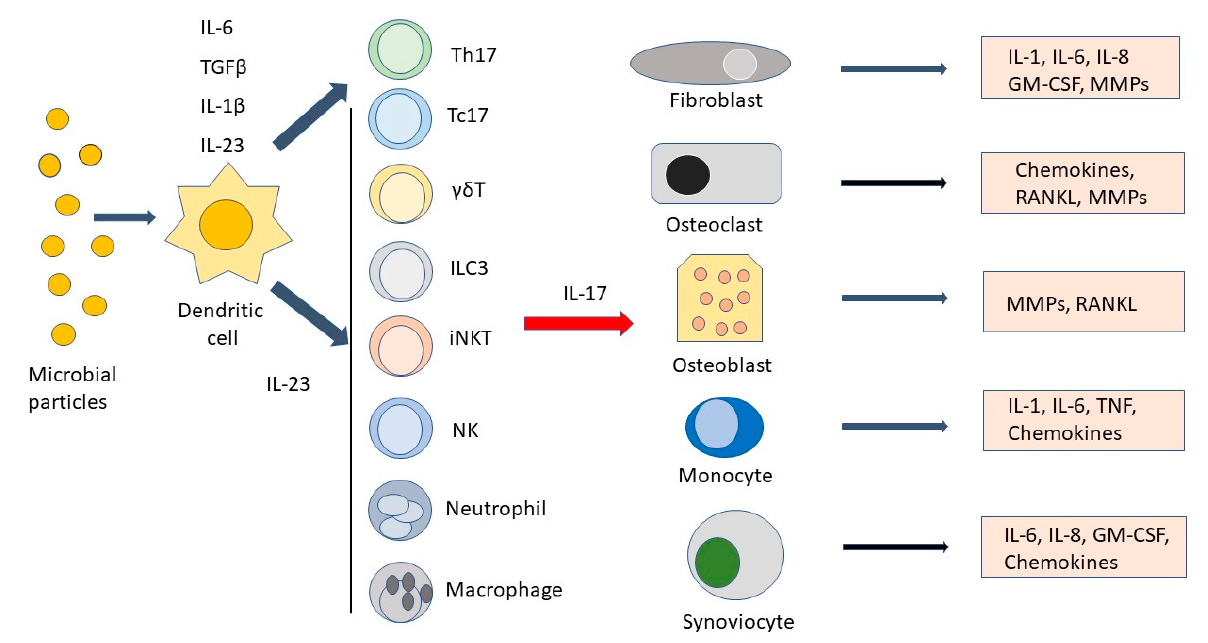
Figure 1. Main cell types and soluble factors involved along the interleukin-23 (IL-23)/IL17 axis. Microbial products are phagocytosed by dendritic cells, which, in turn, induce T helper 17 (Th17) cells to differentiate in the presence of interleukin-1 β (IL-1 β ), IL-6, and tissue-growth factor- β (TGF β ). IL-23 ensures Th17 cell survival and stimulates IL-17 production by Th17 and other cell types such as T cytotoxic 17 (Tc17) cells, γδ T cells, innate lymphoid cells type 3 (ILC3), invariant natural killer cells (iNKT), NK cells, neutrophils, and macrophages. After stimulation by IL-17, fibroblasts, osteoclasts, osteoblasts, monocytes, and synoviocytes produce IL-1, IL-6, IL-8, granulocyte macrophage colony- stimulating factor (GM-CSF), chemokines, tumor necrosis factor (TNF), and matrix metalloproteinases (MMPs), leading to the amplification of the inflammatory response.